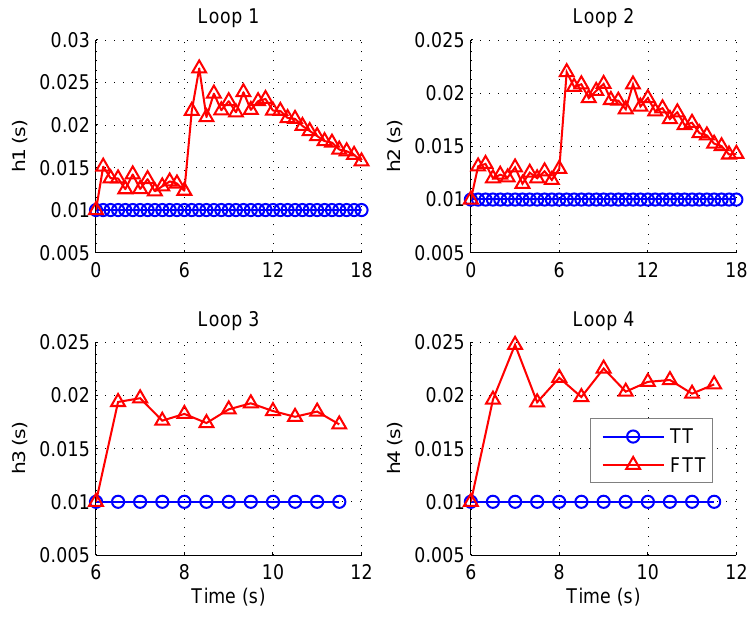
Figure 5. Sampling period under system reconfiguration.